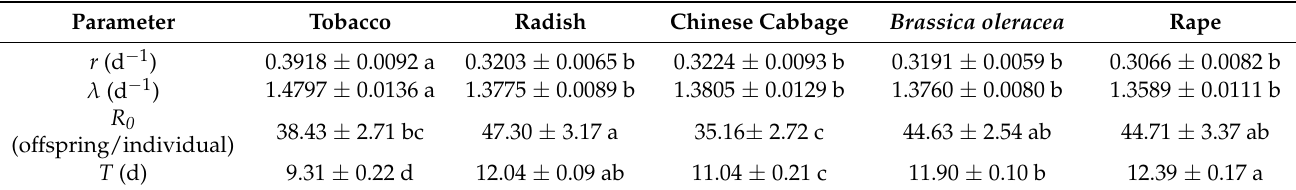
Table 4. Population parameters of M. persicae on five host plants.